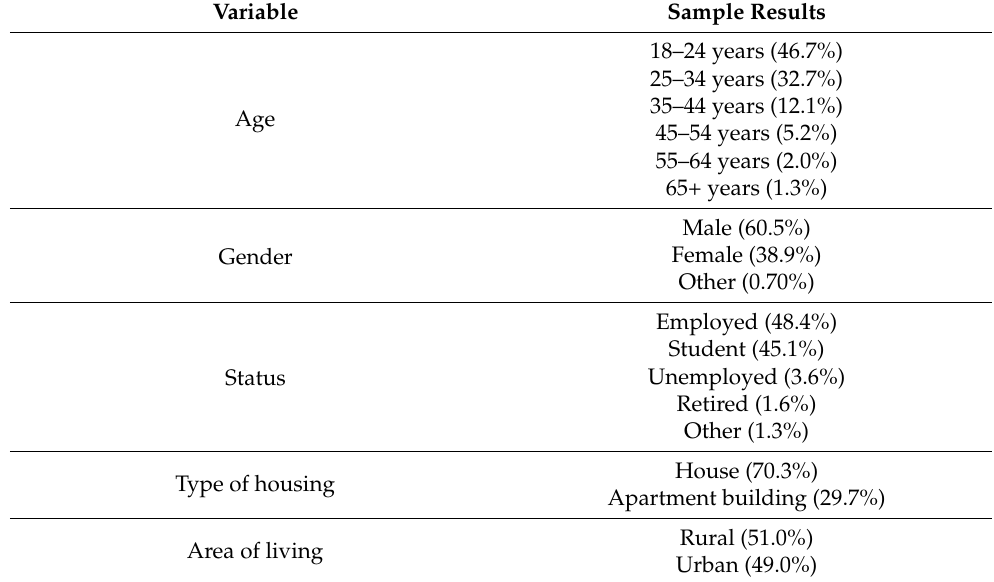
Table 1. Sample of demographics ( n =